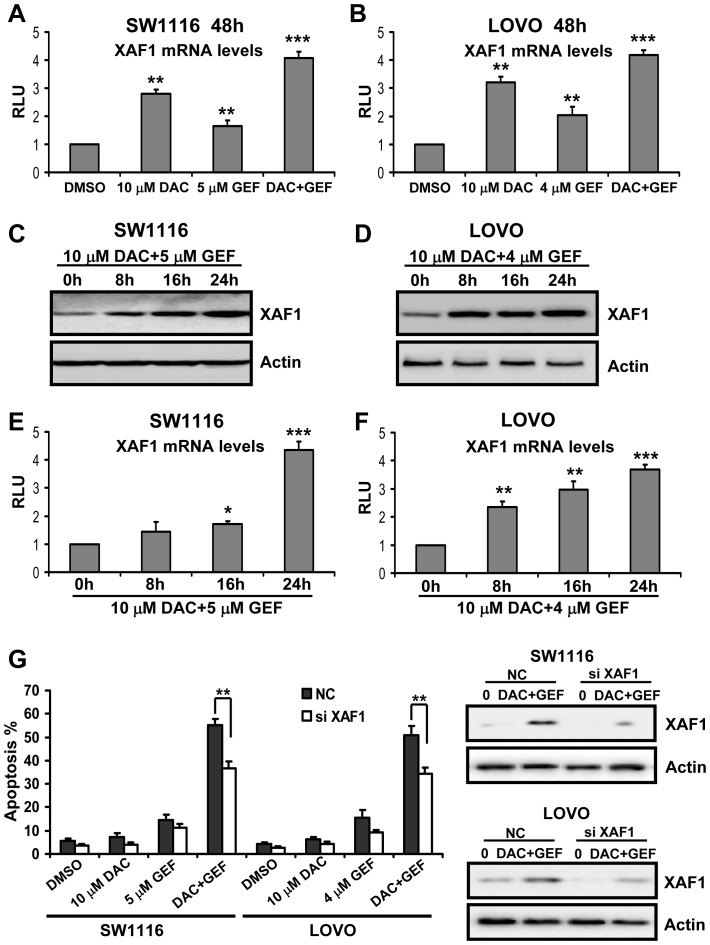
XAF1 plays a critical role in cellular apoptosis triggered by decitabine combined with gefitinib.(A) and (B) SW1116 and LOVO cells were treated for 48 h with the indicated concentrations of decitabine (DAC) and gefitinib (GEF) either alone or in combination. The mRNA expression levels of XAF1 were determined by real-time quantitative PCR. Expression of β-actin served as control. The data are representative of three independent experiments. Columns, mean; bars, SD. **, P<0.01; **, P<0.001. (C) and (D) SW1116 and LOVO cells were treated for the indicated time intervals with the indicated concentrations of DAC and GEF in combination. The expression levels of XAF1 were determined by Western blot analysis as described under methods. Expression of β-actin served as a loading control. The data are representative of three independent experiments. (E) and (F) SW1116 and LOVO cells were treated for the indicated time intervals with the indicated concentrations of DAC and GEF in combination. The mRNA expression levels of XAF1 were determined by real-time quantitative PCR. Expression of β-actin served as control. The data are representative of three independent experiments. Columns, mean; bars, SD. *, P<0.05; **, P<0.01; ***, P<0.001. (G) SW1116 and LOVO cells were treated with 100 nM XAF1 siRNA and negative control (NC) siRNA for 12 h, and treated with the indicated concentrations of DAC and GEF in combination for an additional 48 h. And then the apoptotic cells were determined by Annexin V-FITC/PI staining and flow cytometry analysis (left panel). This experiment was repeated thrice. Columns, mean; bars, SD. **, P<0.01. The knockdown effects on XAF1 were confirmed by Western blot analysis (right panel). The data are representative of three independent experiments.